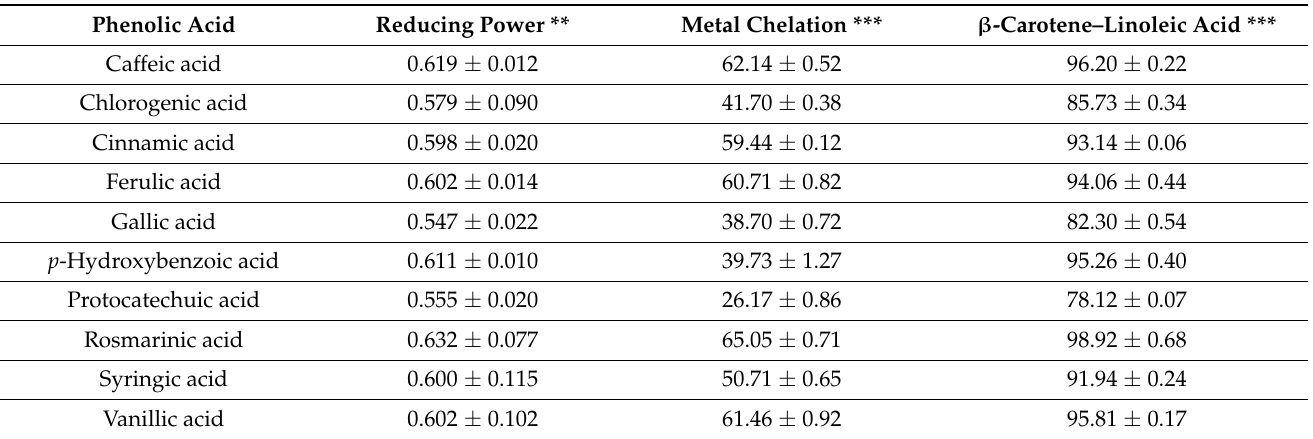
* Adapted from Sevgi et al. [190]. Reducing power significantly and positively correlated with metal chelation (r = 0.7823, p < 0.01) and the β -carotene–linoleic acid assay (r = 0.9566, p < 0.01). Metal chelation significantly and positively correlated with the β -carotene–linoleic acid assay (r = 0.8599, p = 0.01). ** BHT at 0.1 mg/mL (absorbance = 2.012 ± 0.029) and BHA at 0.1 mg/mL (absorbance = 1.114 ± 0.098) were used as positive controls for reducing power. *** EDTA at 2 mg/mL was used as a positive control (chelation effect = 98.40 ± 0.35%). *** BHT at 2 mg/mL (total antioxidant capacity = 86.48 ± 1.93%) and BHA at 2 mg/mL (total antioxidant capacity = 92.14 ± 0.15)